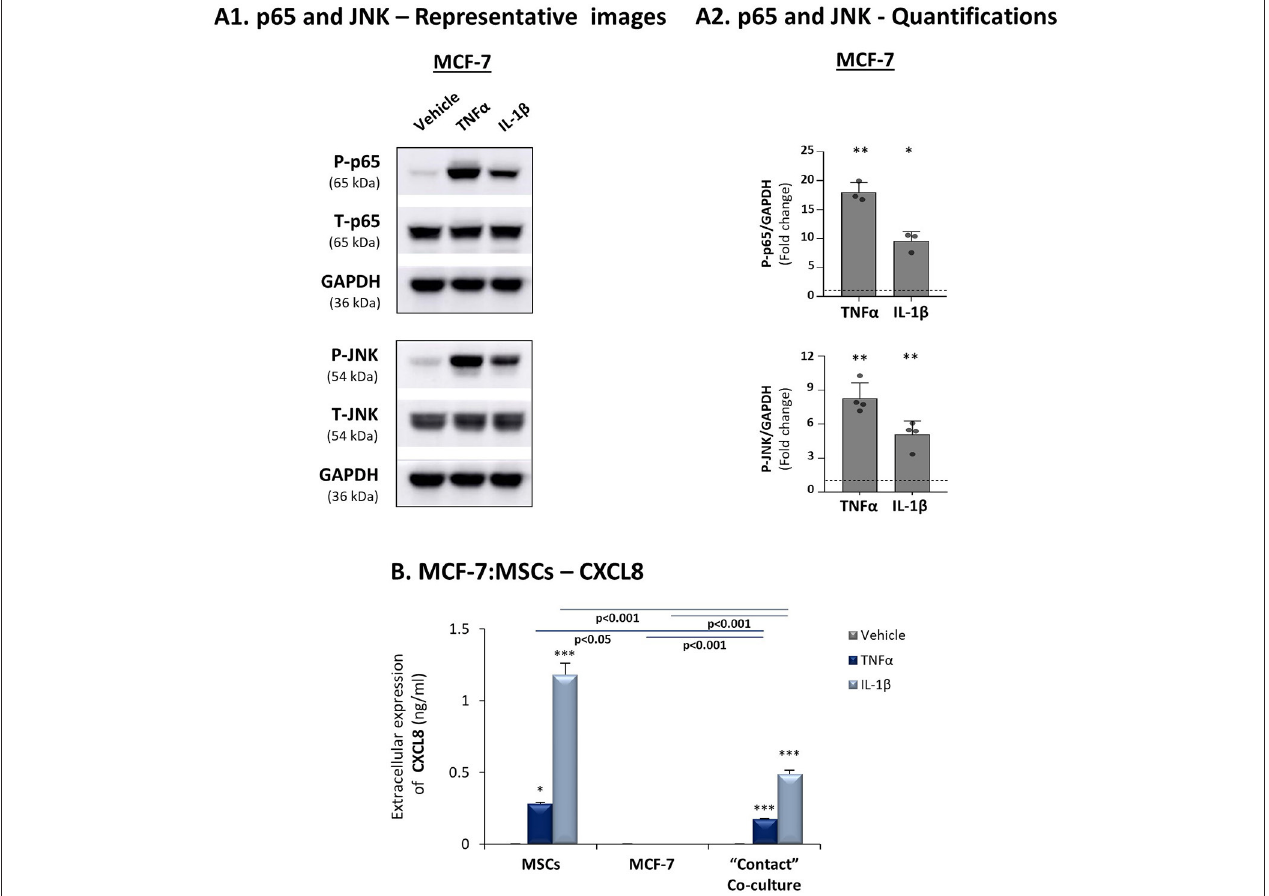
FIGURE 7 | CXCL8 expression is down-regulated in TNF α - and IL-1 β -stimulated luminal-A (MCF-7): MSC “Contact” co-cultures. The Figure demonstrates similar experiments and statistical analyses as those of Figure 3 , performed herein with MCF-7 cells and MSCs. Cytokine concentrations: 50ng/ml TNF α and 500 pg/ml IL-1 β . (A) Activation of p65 and JNK. (B) CXCL8 expression levels. In all parts of the Figure, the results are of a representative experiment of n ≥ 3 independent experiments, performed with MSCs of 2 different donors. *,**,***, # - As described in Figure 3